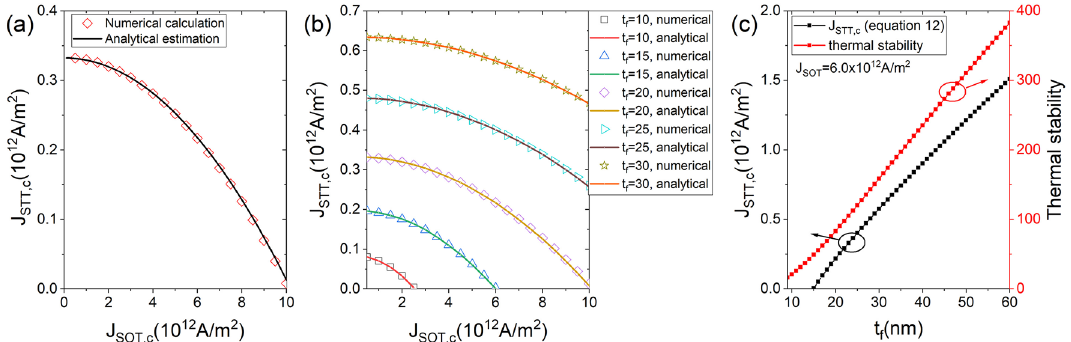
Figure 3. Analytical estimation and numerical calculation of the critical switching current density for a given D = 10 nm. ( a ) t f = 20 nm. J STT,c decreases nonlinearly with increasing J SOT,c . ( b ) t f = 10, 15, 20, 25 and 30 nm. As t f increases, J STT,c increases. ( c ) J SOT,c = 6.0 × 10 12 A/m 2 . As t f increases, J STT,c increases because the barrier height between two stable state increases with increasing t f , where black (red) dotted line indicates the critical switching current density (thermal stability).